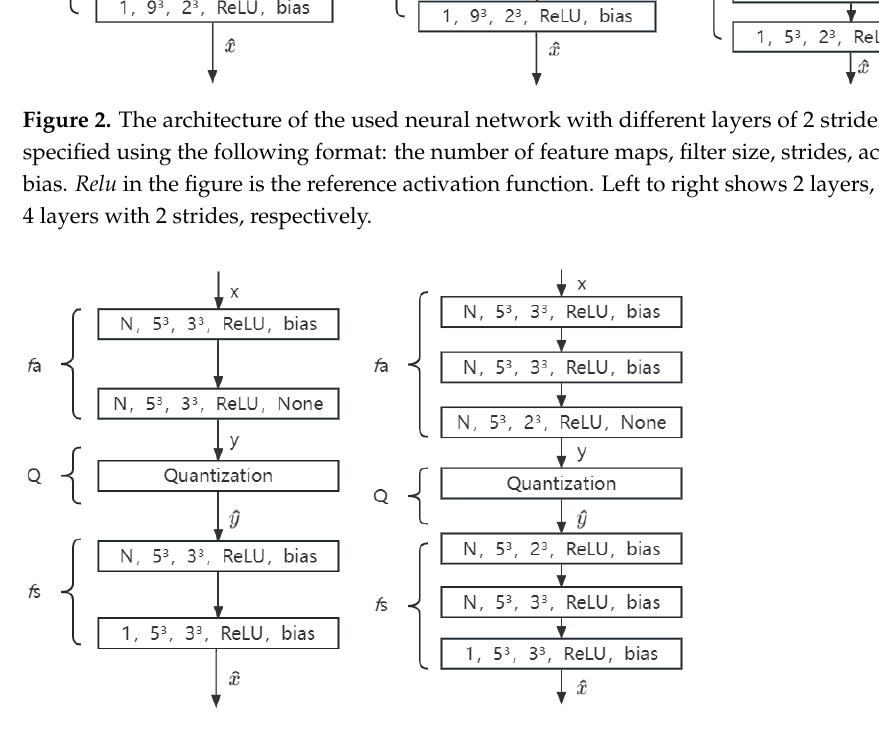
Figure 3. The architecture of the used neural network with different layers of 3 strides. Relu in the figure is the reference activation function. Left to right shows 2 layers and 3 layers with 3 strides,